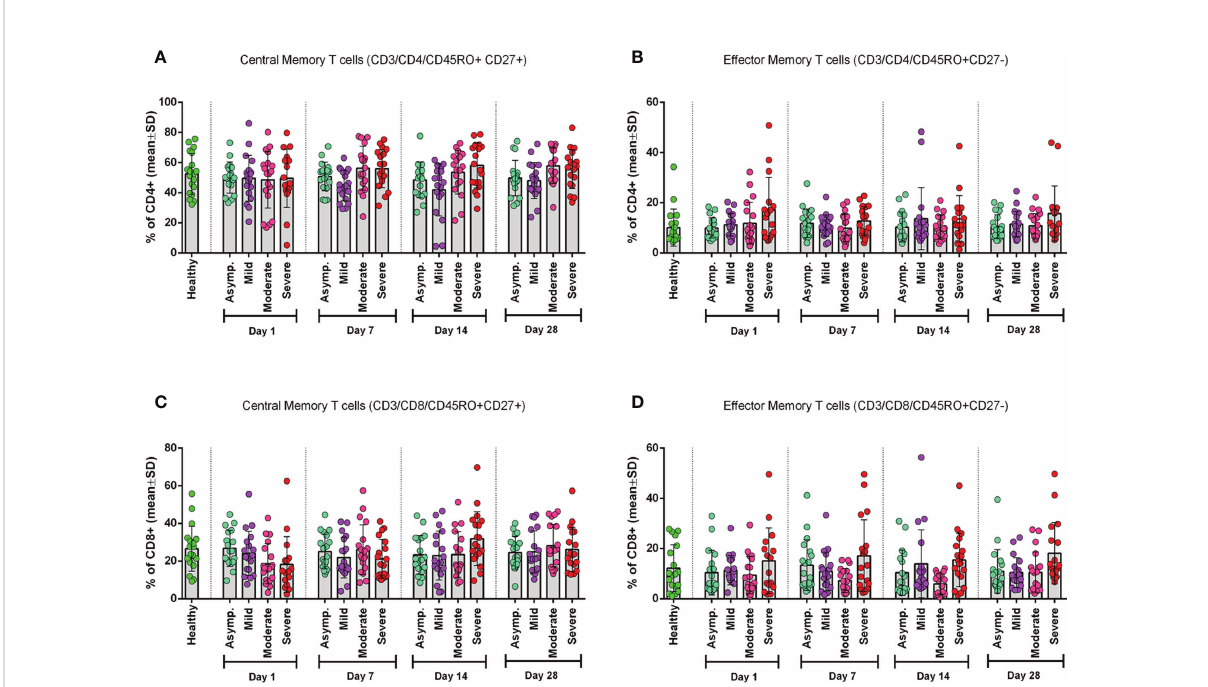
FIGURE 2 Frequency of Memory T cell subtypes in different categories of COVID-19 patients (asymptomatic (n=18), mild (n=19), moderate (n=19), and severe (n=18)) at different day points from the onset of infection and compared with the Healthy controls. (A) CD4+ Central Memory T cells, (B) CD4+ Effector Memory T cells, (C) CD8+ Central Memory T cells, and (D) CD8+ Effector Memory T cells. One-way ANOVA was performed for each of the plots to compare differences of each column with corresponding Healthy control